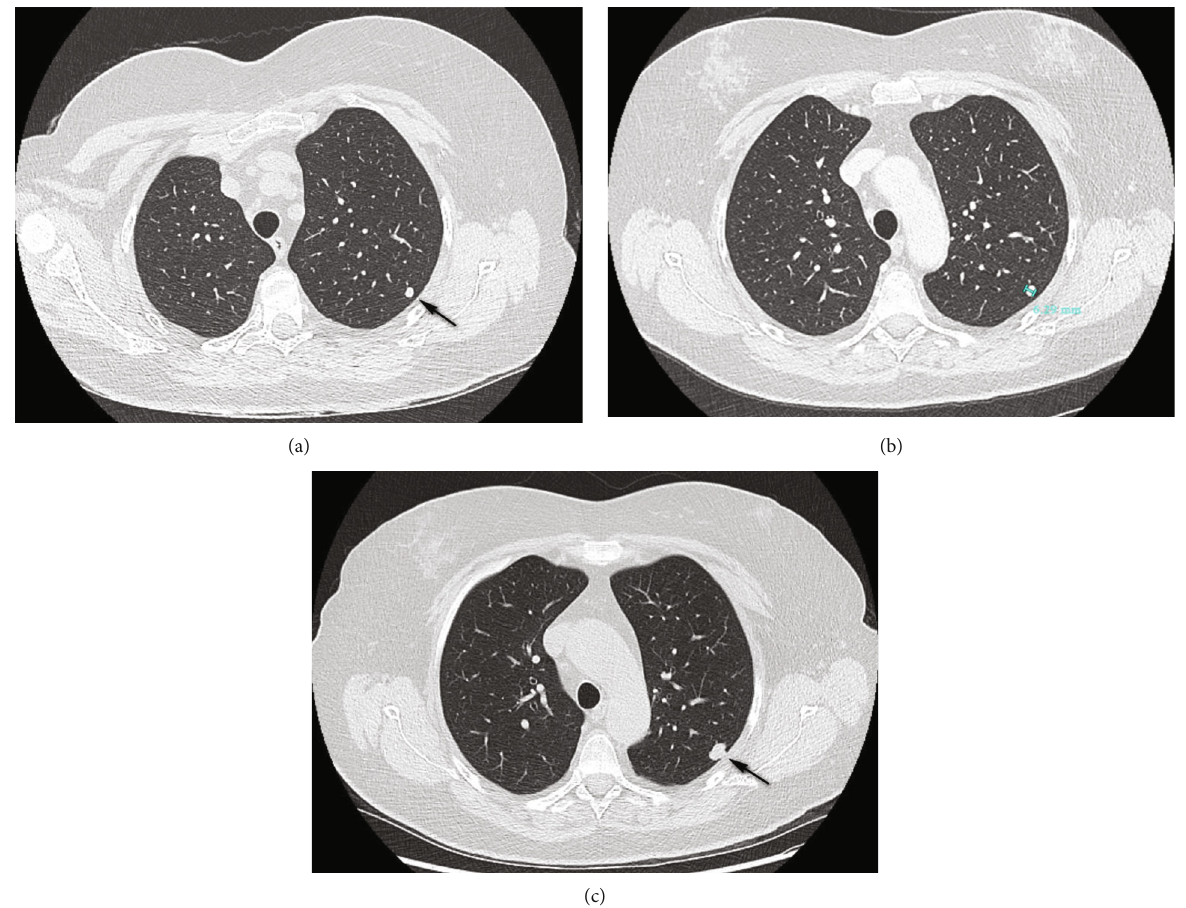
Figure 2: Radiographic images of the suspected metastases. CT scan of a dense opacity in the left upper lung lobe of 6 mm in April 2016 (a). The nodule was unchanged after 6 months of follow-up (b). In December 2019, the nodule increased to 13.5mm